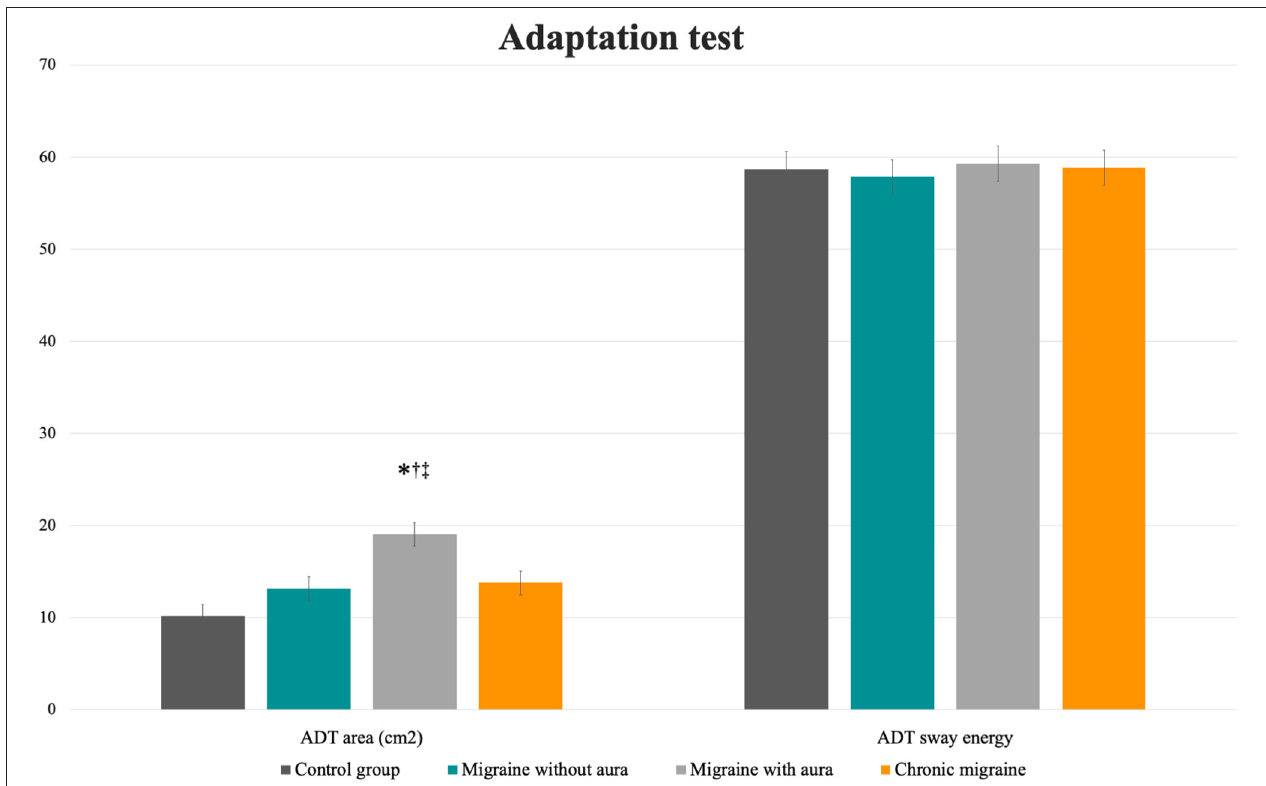
FIGURE 3 | Mean and standard errors of the area (cm 2 ) and sway energy of the adaptation test among patients with migraine with and without aura, chronic migraine, and controls. * p < 0.01 vs. control group; † p < 0.04 vs. migraine without aura; ‡ p = 0.03 vs. chronic migraine.